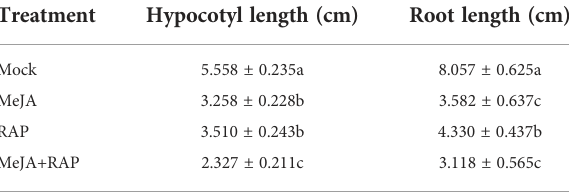
TABLE 1 Effect of treatment with MeJA and RAP on tomato seedling growth.